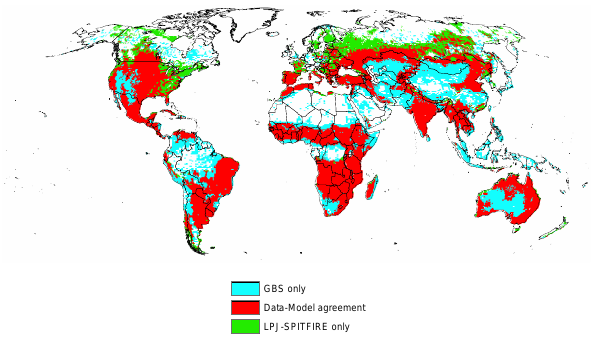
Fig. 7. Comparison of simulated and observed (GBS) area burnt, 1982–1999. Red areas: both GBS and the model show fires. Blue areas: GBS sees fires, while none are simulated. Green areas: the model simulates fires, while none are seen by GBS.